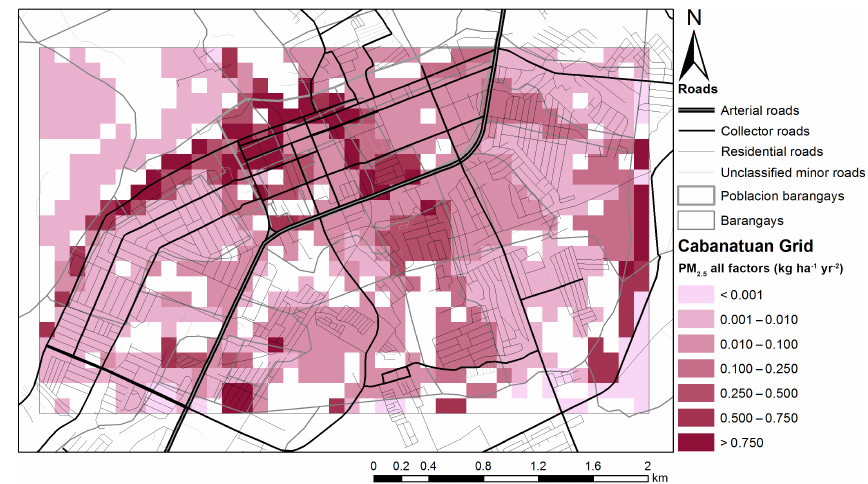
Figure 9. Map of estimated PM 2 . 5 emissions combining all factors in the study. Base map derived from satellite imagery (Google Earth Pro, 2015,